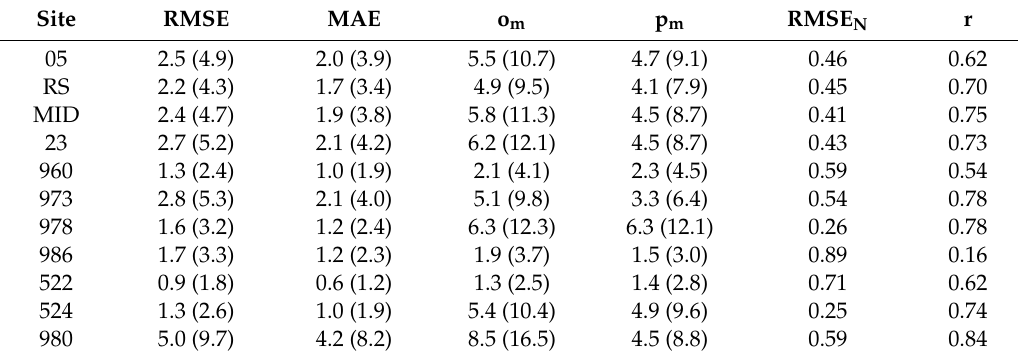
Table 2. Skill scores of hourly forecasts for mean wind speed at di ff erent locations of the Madeira Island (see locations in Figure 1). The values of root-mean-squared error (RMSE), mean absolute error (MAE), average values of observations (o m ) and forecasts (p m ) are displayed in m s − 1 and kt (in parenthesis). The normalized RMSE (RMSE N ), defined as RMSE / o m , and the correlation coe ffi cient, r, are also shown. RMSE MAE o m p m